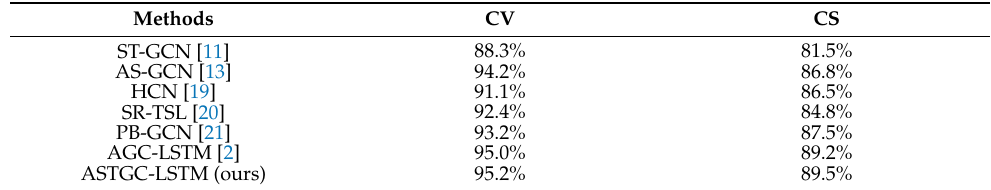
Table 2. Comparison with state-of-the-art methods, using the NTU-RGB+D dataset, for Cross-View (CV) And Cross-Subject (CS) evaluations of accuracy.